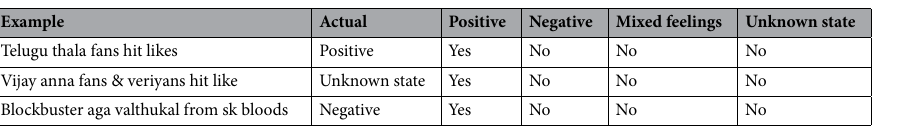
Table 6. Error analysis of samples—sentiment